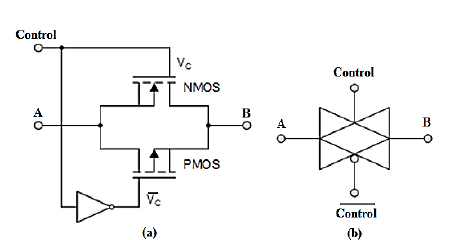
Figure 1. (a) Circuit Diagram of Transmission gate (b) Symbol of Transmission gate In parallel to the inverter which provides two complementary signal voltages between the NMOS gate and the PMOS, two MOS transistors are connected back-to- back. When VC is LOW, the NMOS and PMOS are indeed cut off and the switch opened [14]. When the input control signal is LOW If the VC is high, the two transistors are biased and the switch is shut off. Therefore, if VC = 1, the gate functions as a 'locked' switch, and when VC = 0 is a voltage-controlled switch the gate is an 'opened' switch. The symbol bubble showing the PMOS FET gate